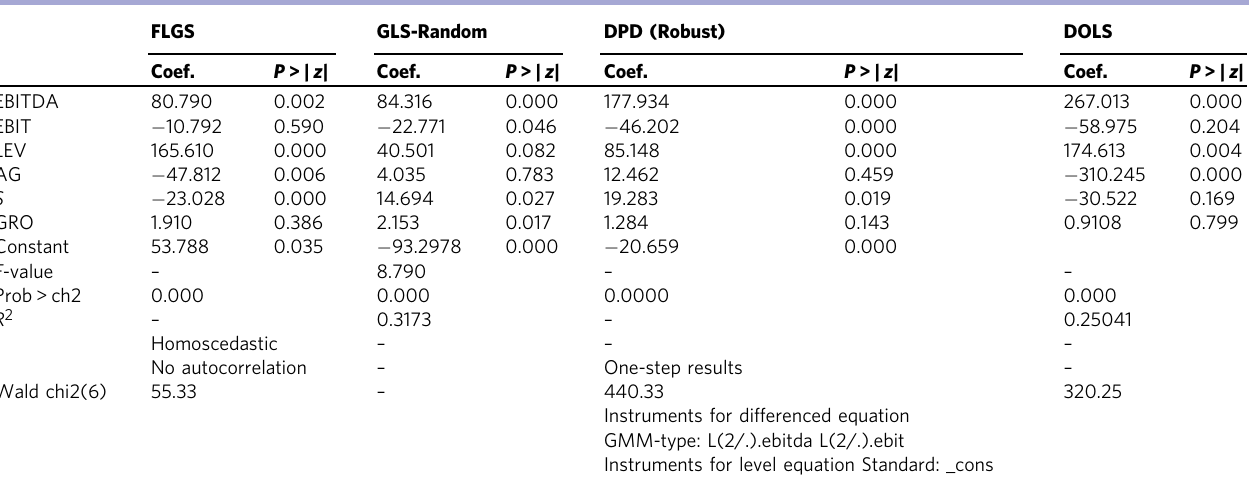
Table 8 Results of FGLS, DPD, GLS, and DOLS.